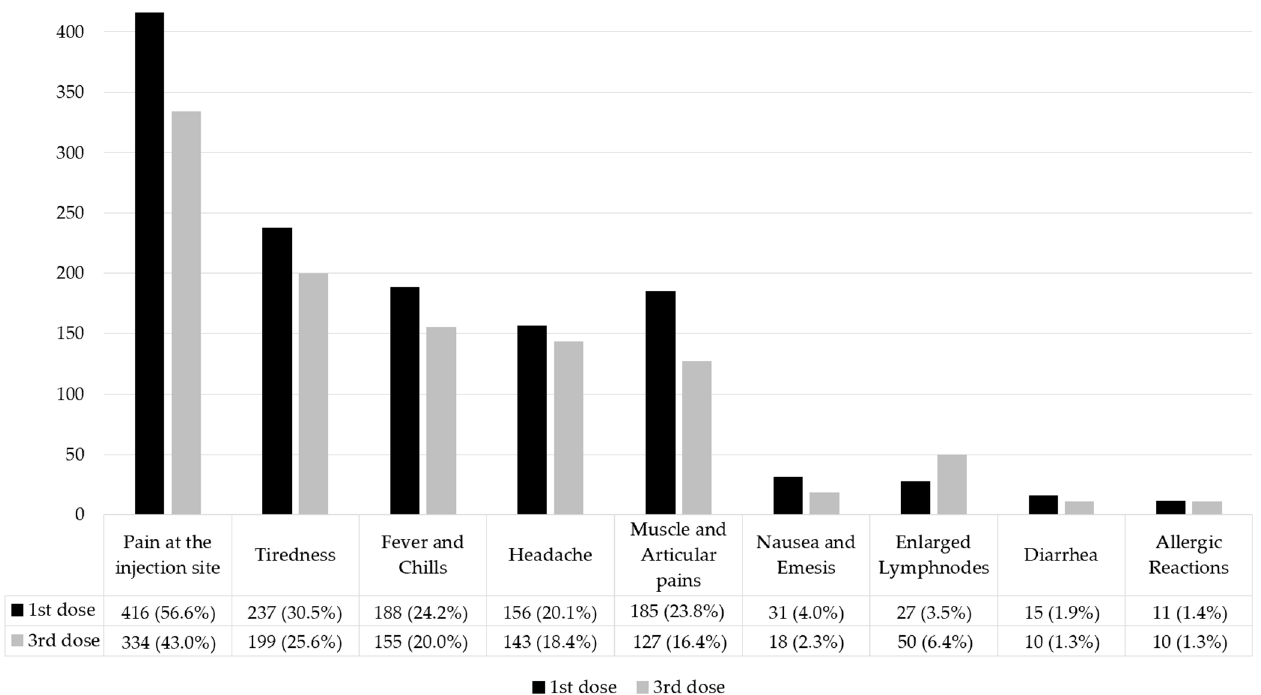
Figure 1. Vaccination side effects. Distribution of vaccination side effects at the start (1st dose) and end (3rd dose) of the vaccination cycle. Values are expressed as numbers and percentages (n (%)) for categorical variables.